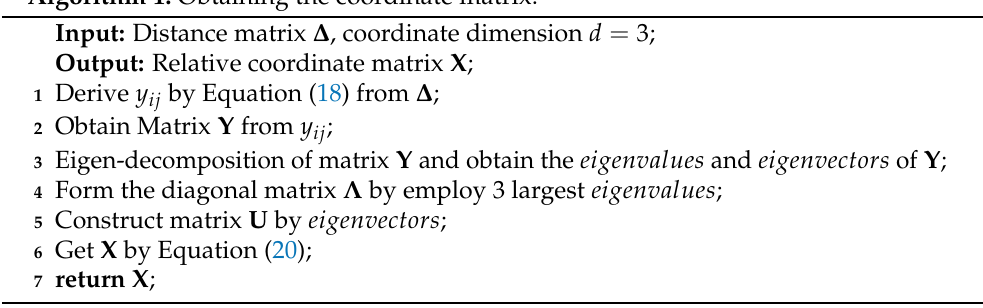
Algorithm 1: Obtaining the coordinate